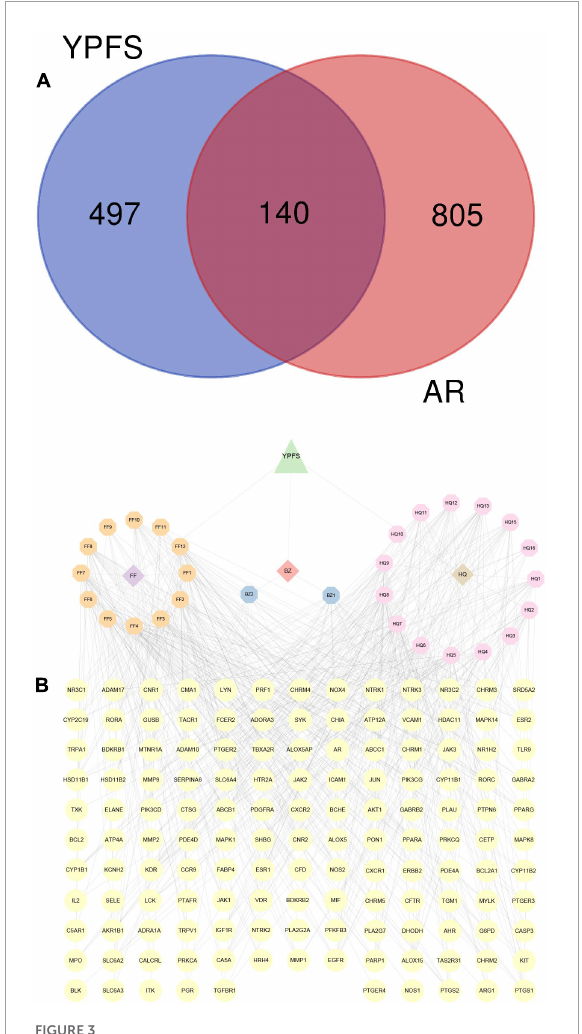
FIGURE3 Screening for AR/YPFS-related genes. (A) Venn analysis of the common targets of YPFS and AR-associated genes. (B) The interaction network is constructed using ingredients and targets genes. The orange, blue, and pink octagons represent the active ingredients of the three herbs in YPFS. FF1-12 are active ingredients of Saposhnikoviae Radix (Fangfeng, FF), BZ1-2 are active ingredients of Atractylodis Macrocephalae Rhizoma (Baizhu, BZ), and HQ1-16 are active ingredients of Astragali Radix (Huangqi, HQ). The full names of the corresponding active ingredients are listed in Supplementary Table 7 . The yellow circles represent the common targets of YPFS and AR-related genes, and the edges represent the interactions between the ingredients and the targets. YPFS, YU-Pingfeng San; AR, allergic rhinitis.